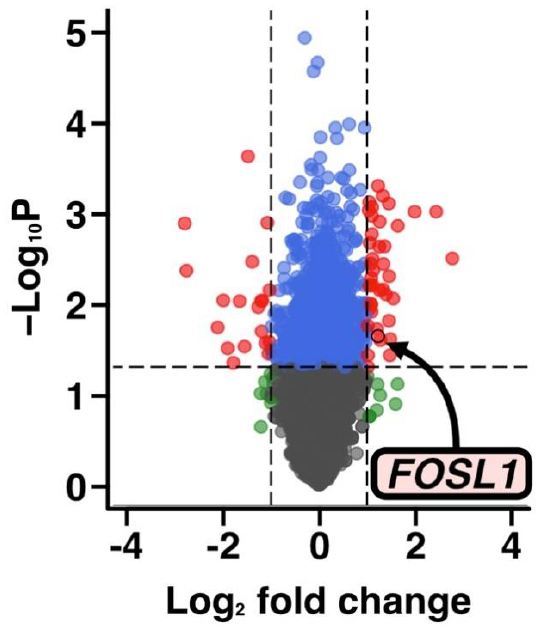
Figure 3. Volcano plot of the DNA microarray results. The volcano plot was created using the microarray results using SF samples from three patients (patient No. #1, #2, and #4). The arrow indicates the FOSL1 gene. Table 2. GO analysis of the DNA microarray results.